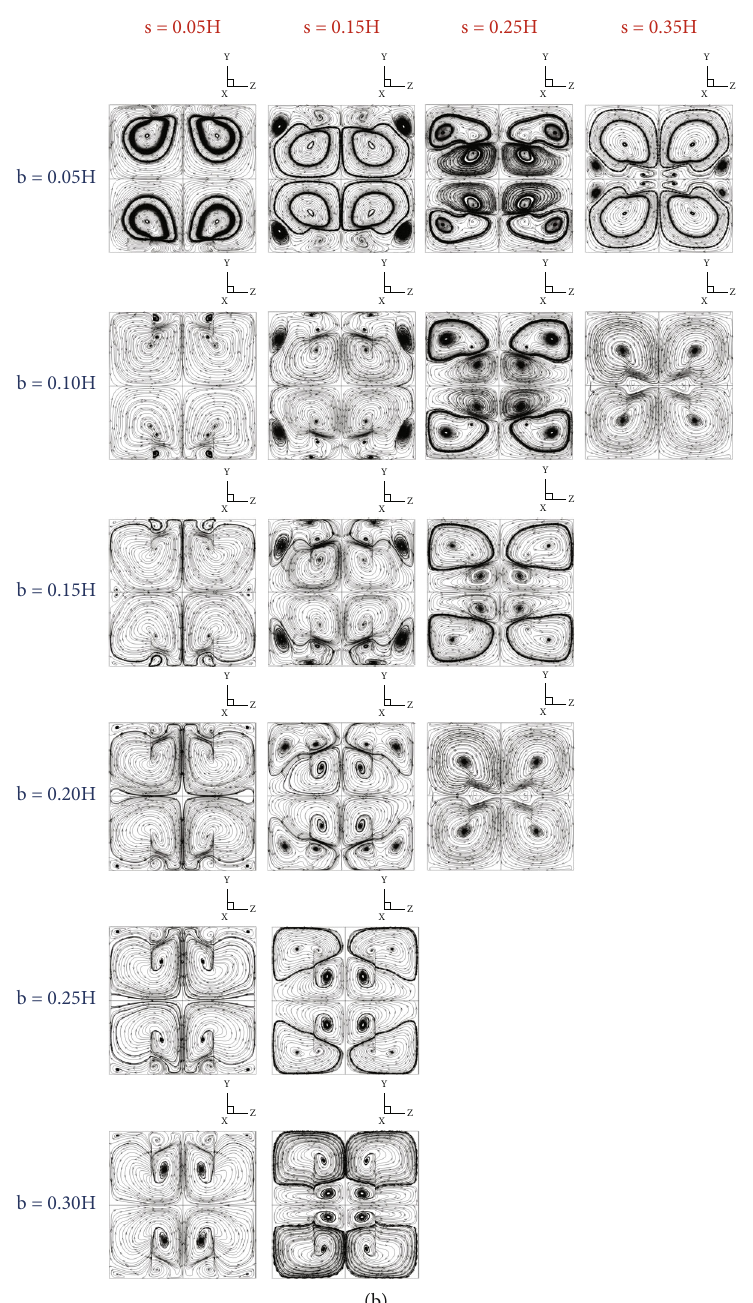
Figure 3: Streamlines in cross sectional planes for the ba ffl ed duct with various b / H and s / H at Re = 800 of (a) VD and (b)